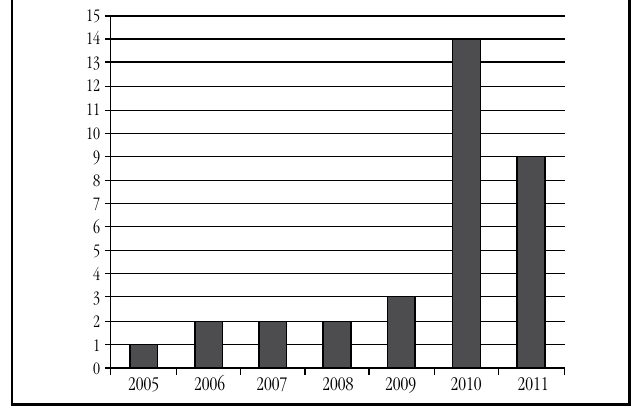
figurA – Schistosomiasis cases reported annually in the city of Divinópolis-MG in the period 2005-2011 tABLE 2 – Number of schistosomiasis cases reported annually according to age group in the city of Divinópolis-MG in the period 2005-2011